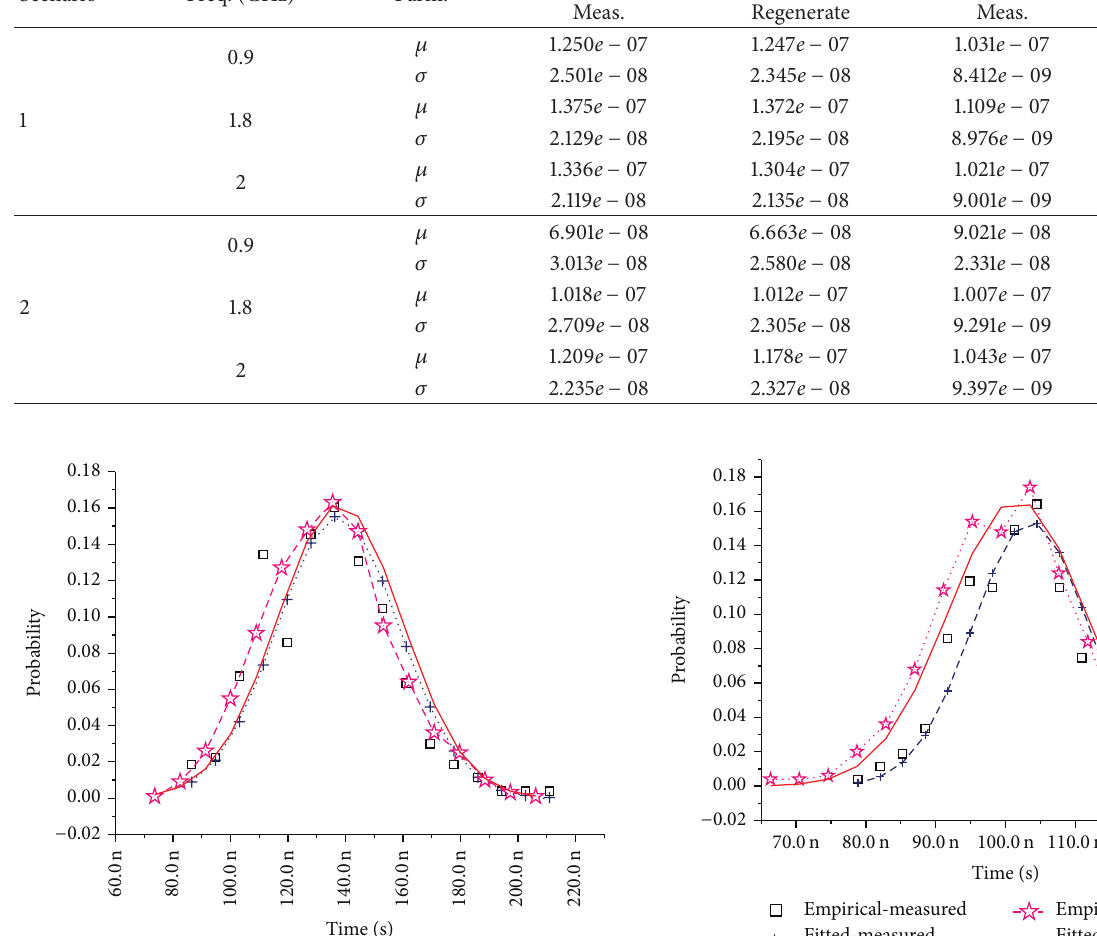
Table 4: Average excess delay and delay spread, the parameters of the fitted normal distributions. Scenario Freq. (GHz) Parm.